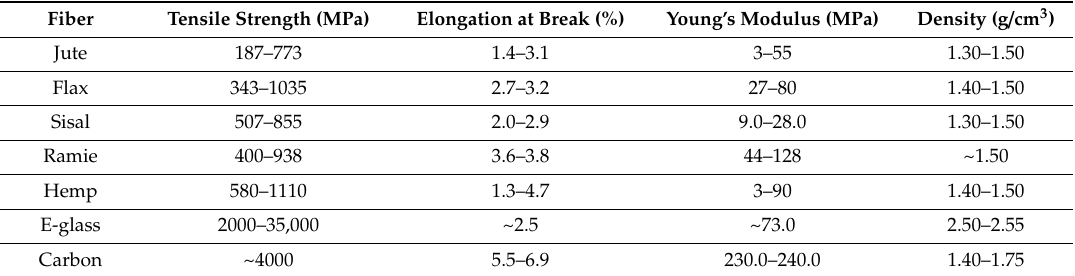
Table 1. The physical properties of natural fibers compared with conventional synthetic